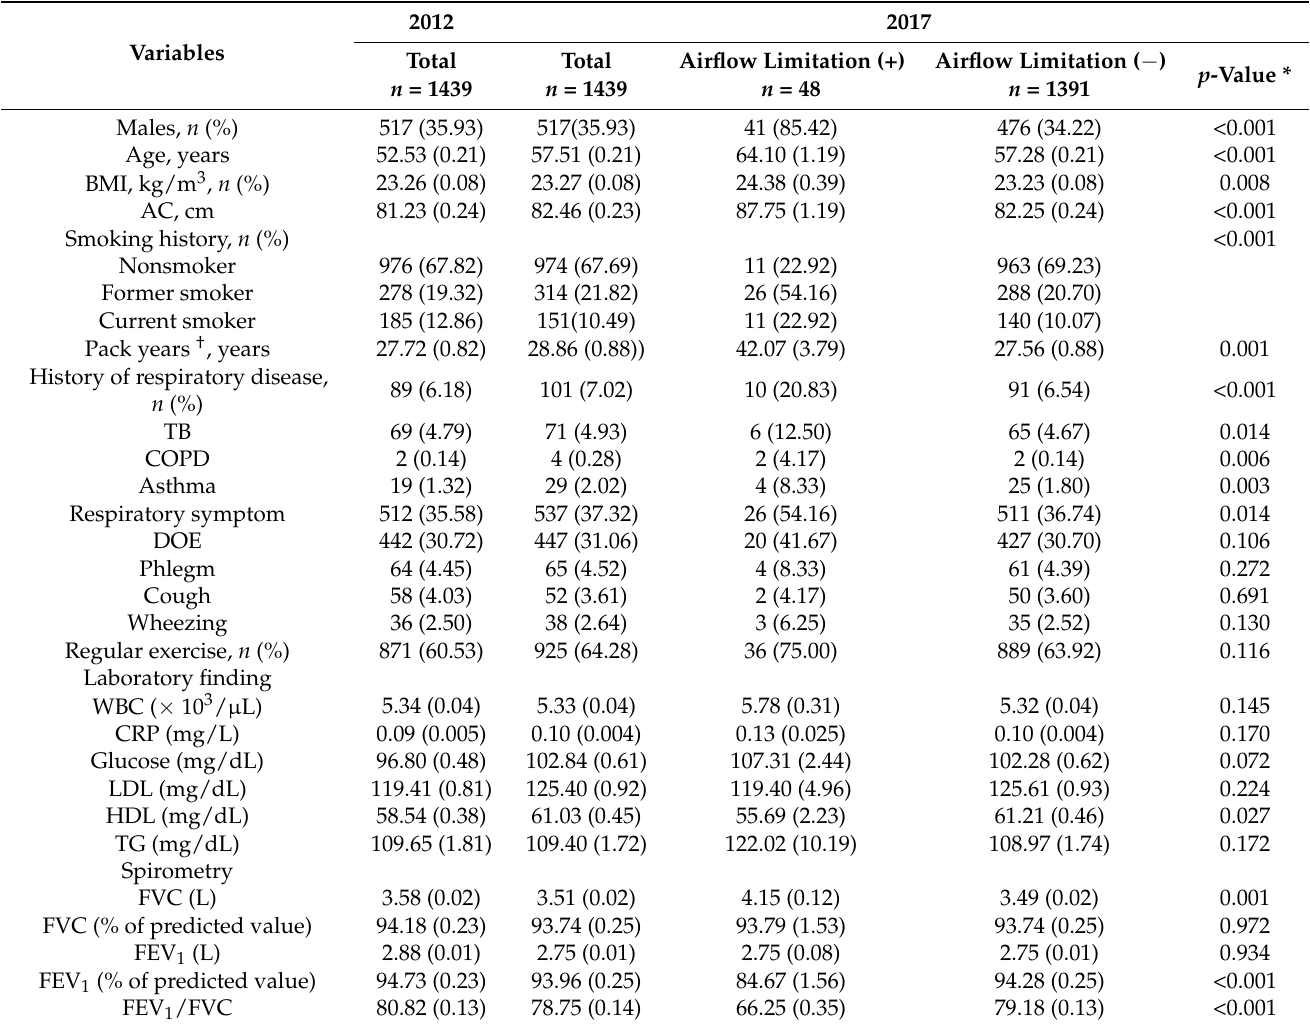
Table 1. Baseline characteristics of the study subjects according to the presence of a new airflow limitation at a 5-year follow-up.